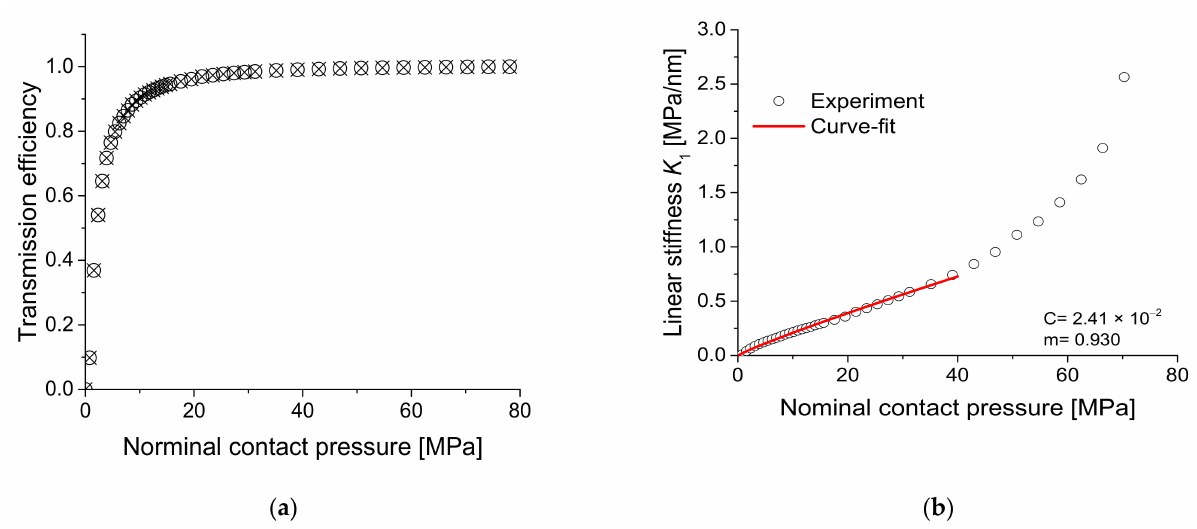
Figure 11. ( a ) Measured transmission efficiency and ( b ) linear stiffness with power-law fitting with respect to contact pressure for specimen